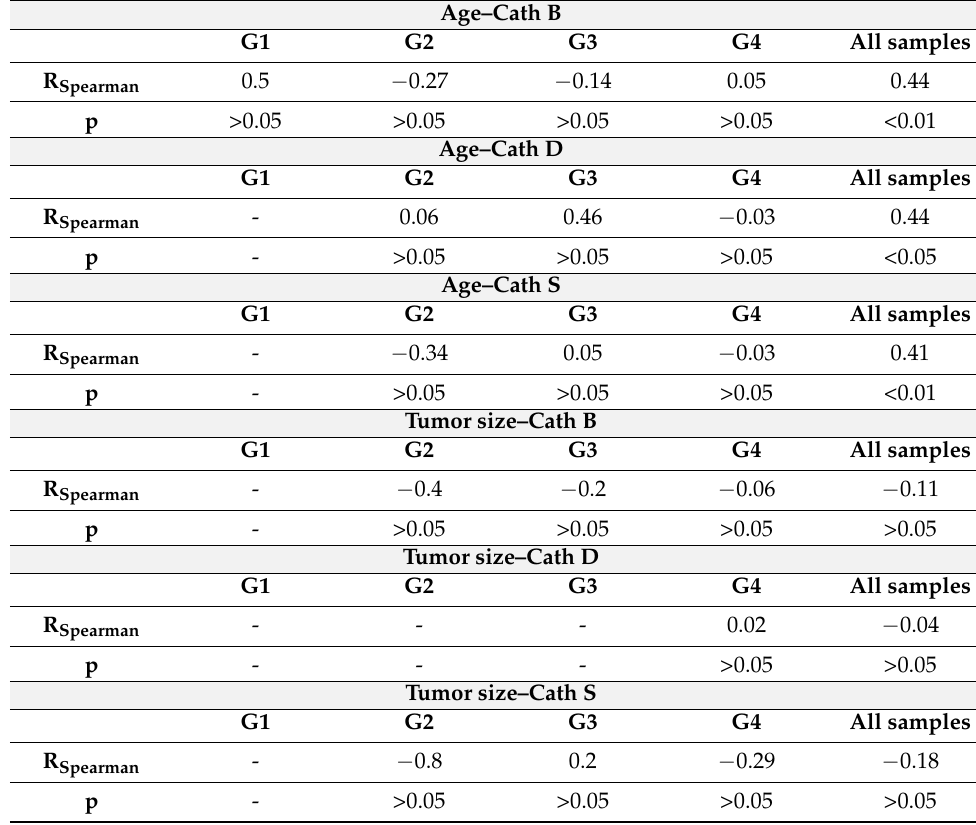
Table A2. Correlations: protein concentration–patient’s age and protein concentration–tumor size.